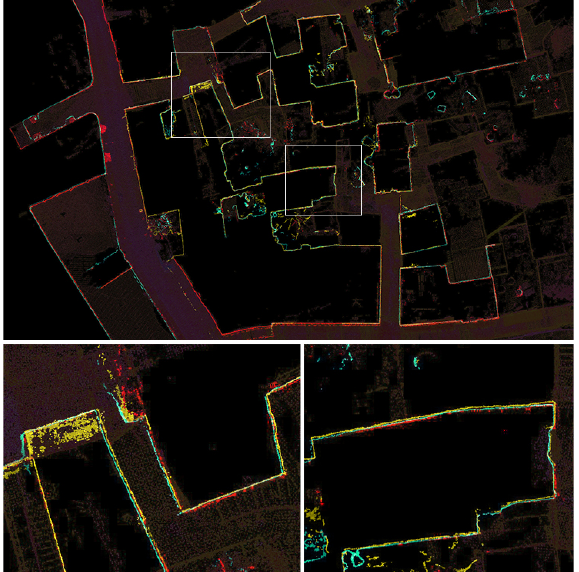
Figure 16: The results of the overlapping on Al-Anatreh’ cluster. The Faro line (red), the Phantom (blue) and the Spark (yellow).